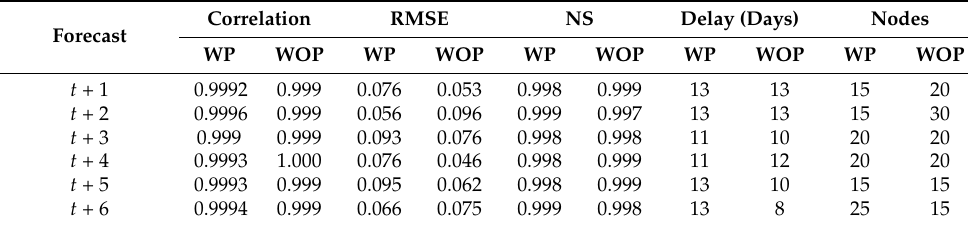
Symbology. W = models with precipitation, WOP = models without precipitation, RMSE = root mean square error, NS = Nash–Sutcliffe